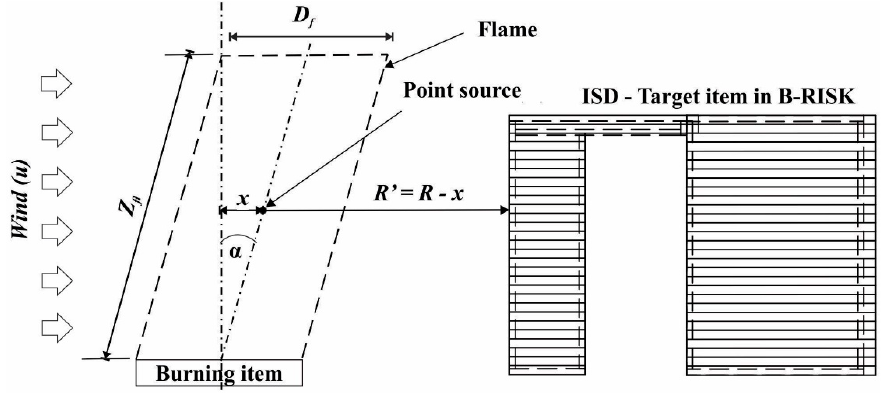
Figure 4. PSM geometry between the burning and target items with wind effects [10]. Used with permission from Elsevier.